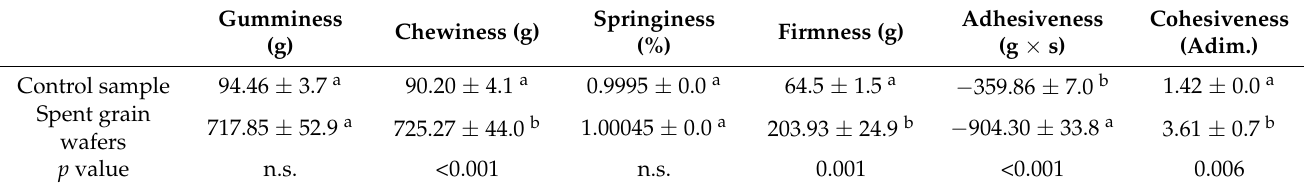
Table 2. Wafer batter textural